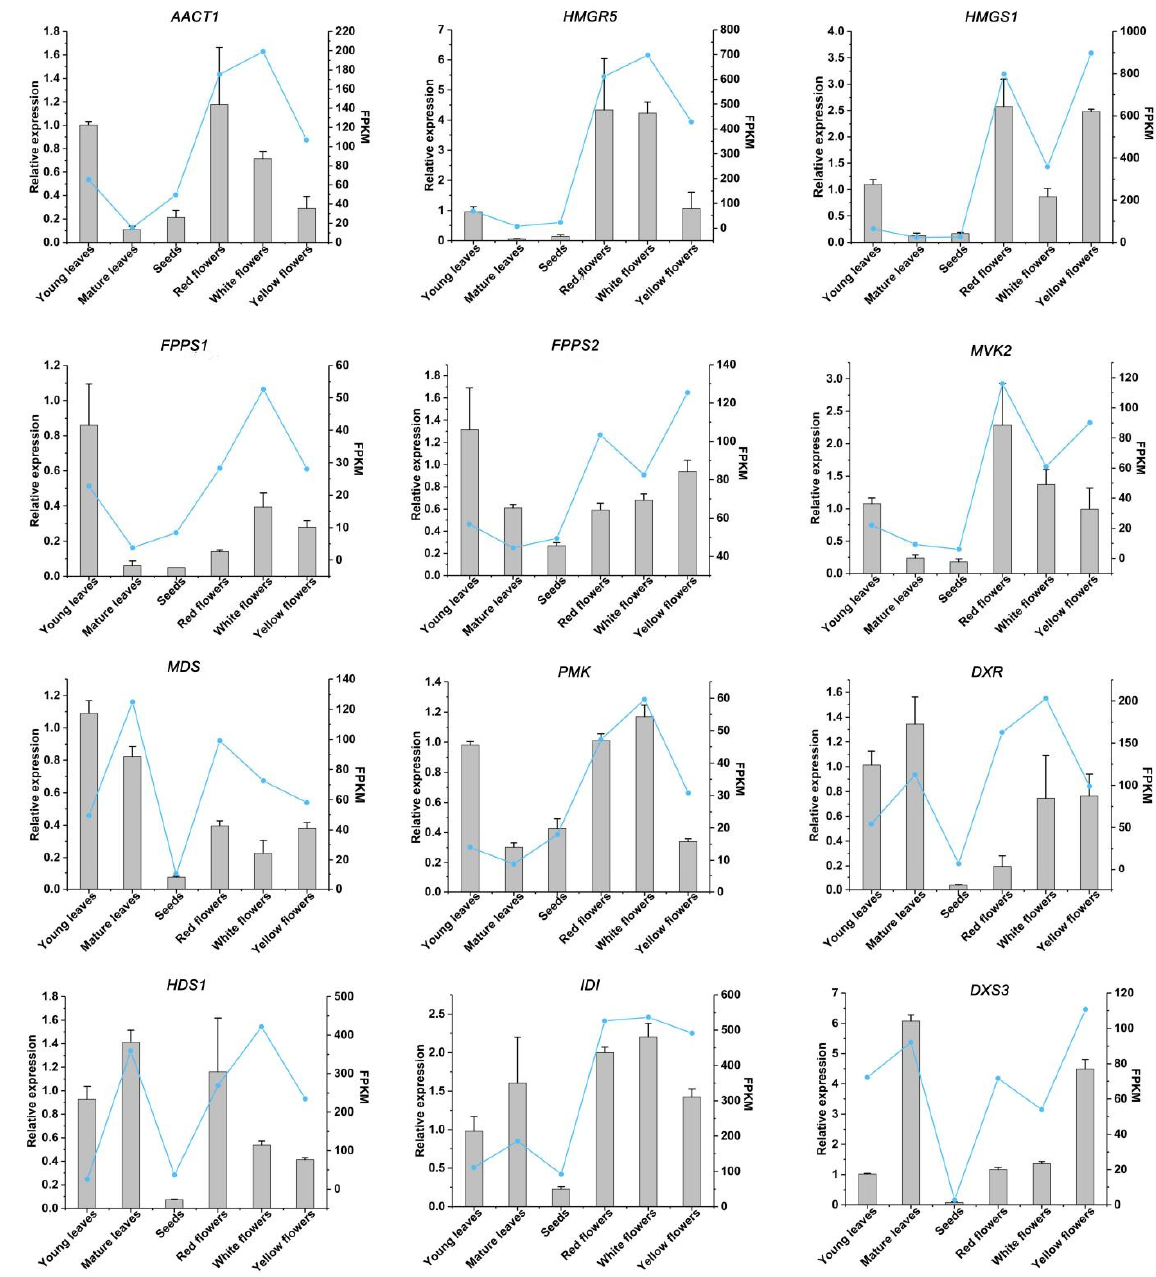
Figure 8. qRT-PCR and RNA-Seq analysis of 12 terpenoid-pathway-related candidate unigenes in sacred lotus. FPKM terms of various plants parts were determined by RNA-seq. Relative expression of genes was calculated using young leaves as control. Standard error of the mean for three biological replicates is represented by the error bars. AACT , Acetyl-CoA C-acetyltransferase; HMGS , hydroxymethylglutaryl-CoA synthase ; HMGR , hydroxymethylglutaryl-CoA reductase (NADPH) ; FPPS , farnesyl diphosphate synthase ; MVK , mevalonate kinase ; MDS , 2-C-methyl-D- erythritol 2,4-cyclodiphosphate synthase ; PMK , phosphomevalonate kinase ; DXR , 1-deoxy-D-xylulose-5-phosphate reductoisomerase ; IDI , isopentenyl-diphosphate Delta-isomerase ; DXS , 1-deoxy-D-xylulose-5-phosphate synthase .